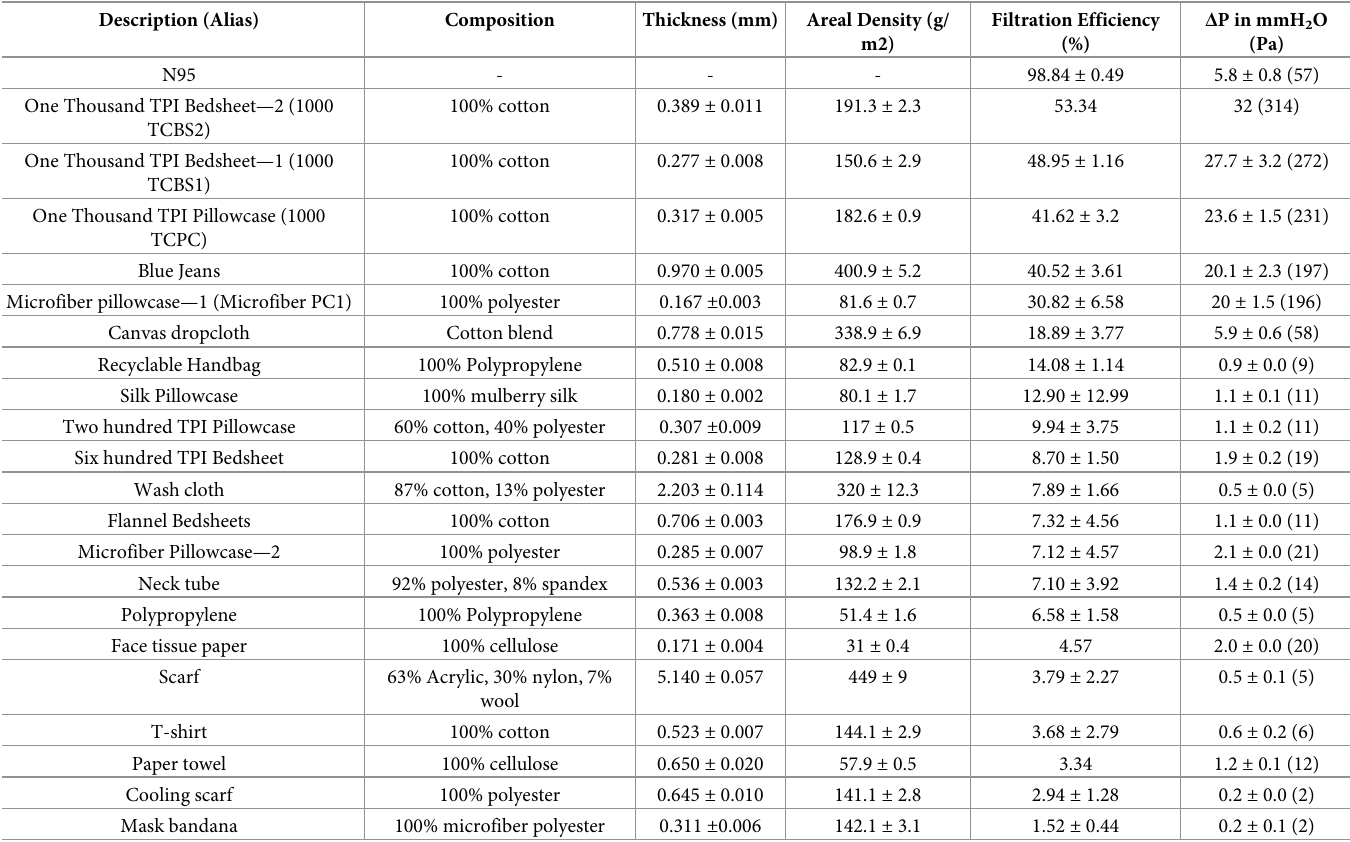
Table 1. Different materials selected, and their properties including dry filtration efficiencies, and pressure drop at velocity 9 cm/s. Description